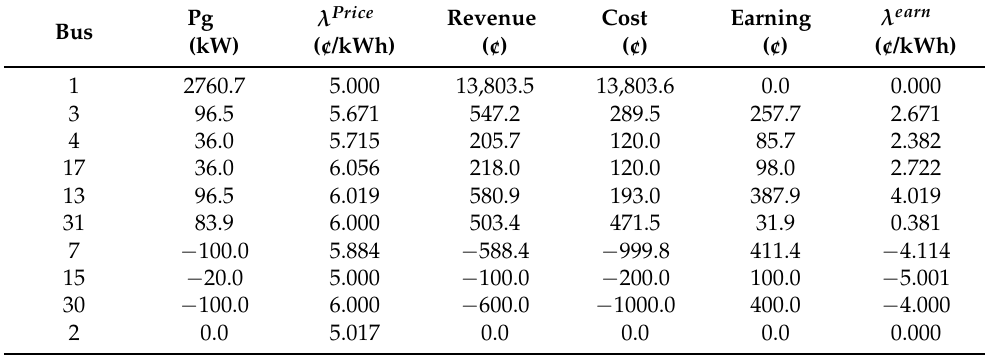
Table 4. Market Results.